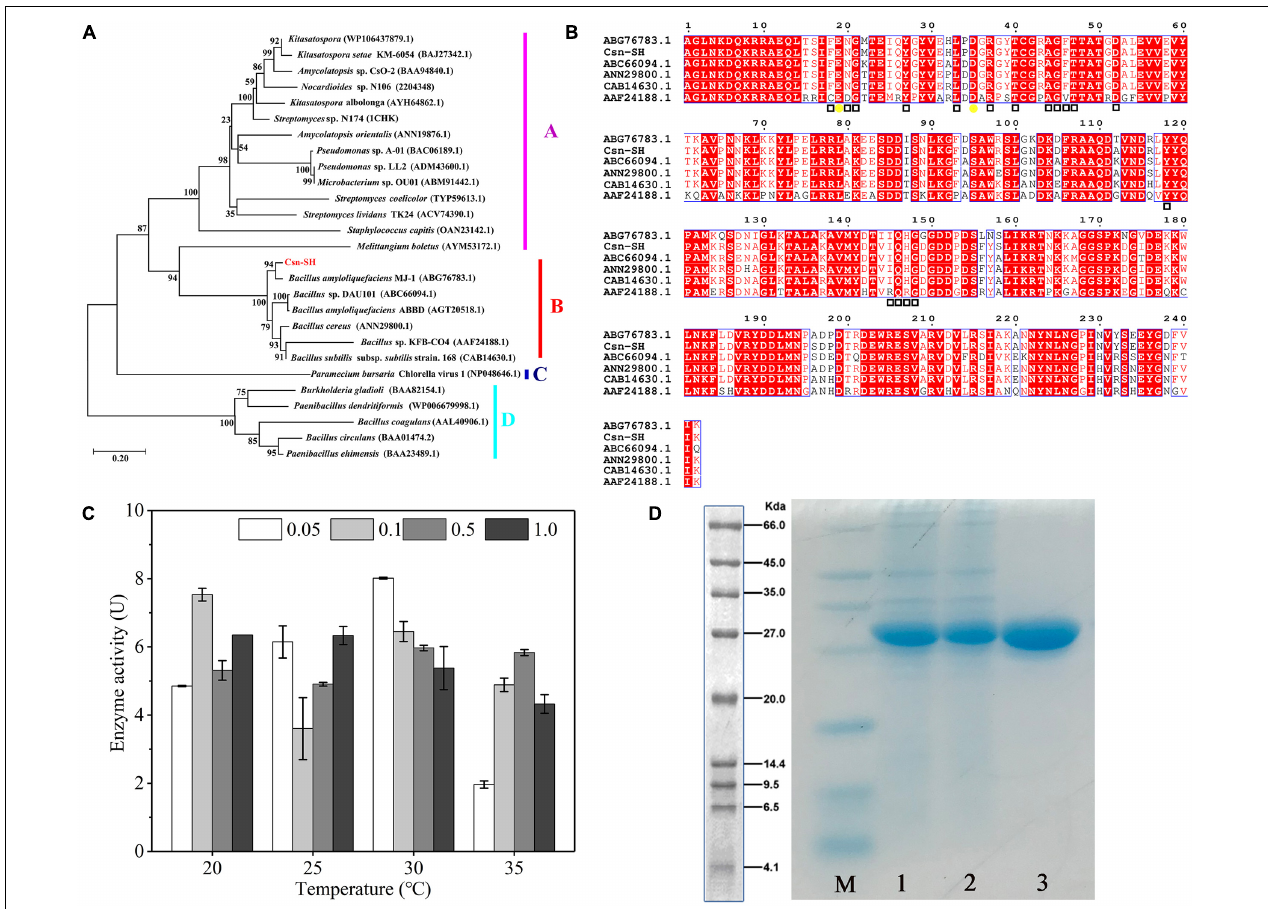
FIGURE 1 | Sequence analysis, expression, and purification of Csn-SH. (A) The neighbor-joining tree shows phylogenetic relationships between Csn-SH and other GH46 family members. The scale bar indicates the average number of amino acid substitutions per site. The bootstrap test of the tree was performed with 1,000 replications. (B) Sequence alignment of Csn-SH with other GH46 family members. The catalytic sites and sugar-binding sites were marked with yellow circles and hollow squares, respectively. The sequence of Csn-SH did not include the 32-amino-acid residues (signal peptide) at N-terminus. (C) The enzyme activities of Csn-SH induced by different concentrations of IPTG at different temperatures, whereas 0.05, 0.1, 0.5, and 1.0 indicated the concentration (mM) of IPTG. (D) SDS-PAGE analysis of purified Csn-SH. M, molecular marker; 1 and 2, crude enzymes induced by 0.05 mM IPTG at 30 ◦ C; 3, purified Csn-SH.